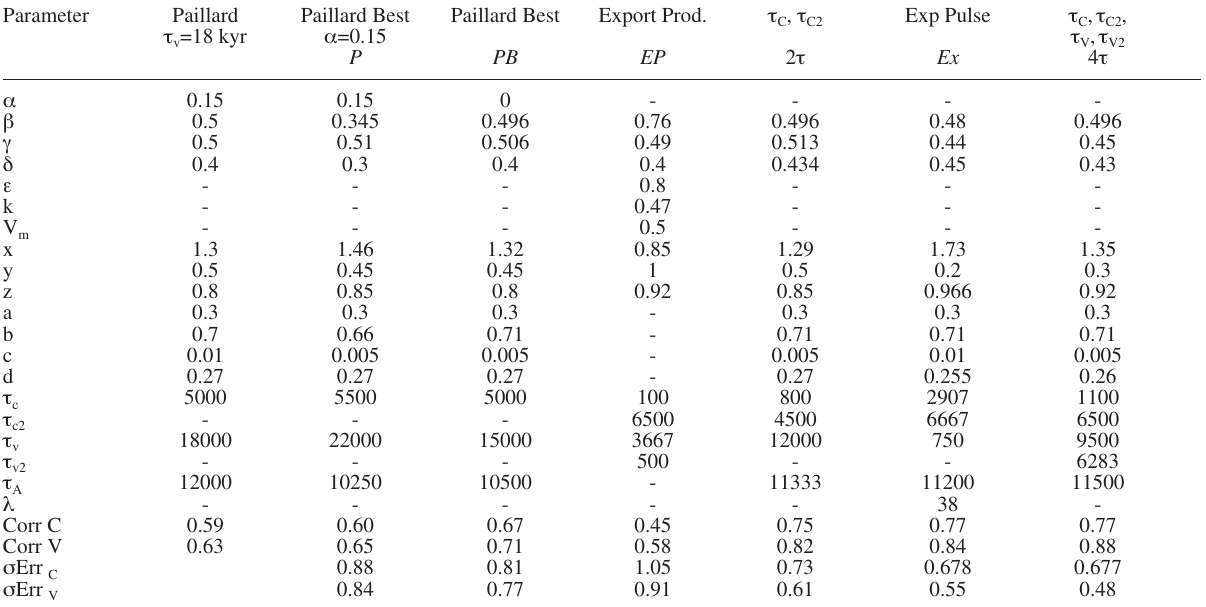
t Able 1. – Central values of the models studied. Columns 2 to 8 correspond to: (2) Paillard (2004) model with t previous model with a =0.15 (model P ); (4) best fit of previous model (model PB ); (5) model with export production (model EP ); (6) model with two relaxation times for C (model 2 t ); (7) previous model with oceanic pulse exponentially dependent on stratification (model Ex ); (8) model with two relaxation times for V (model 4 t ). The last four lines respectively correspond to correlation for CO deviation of error time series for C , and standard deviation of error time series for V